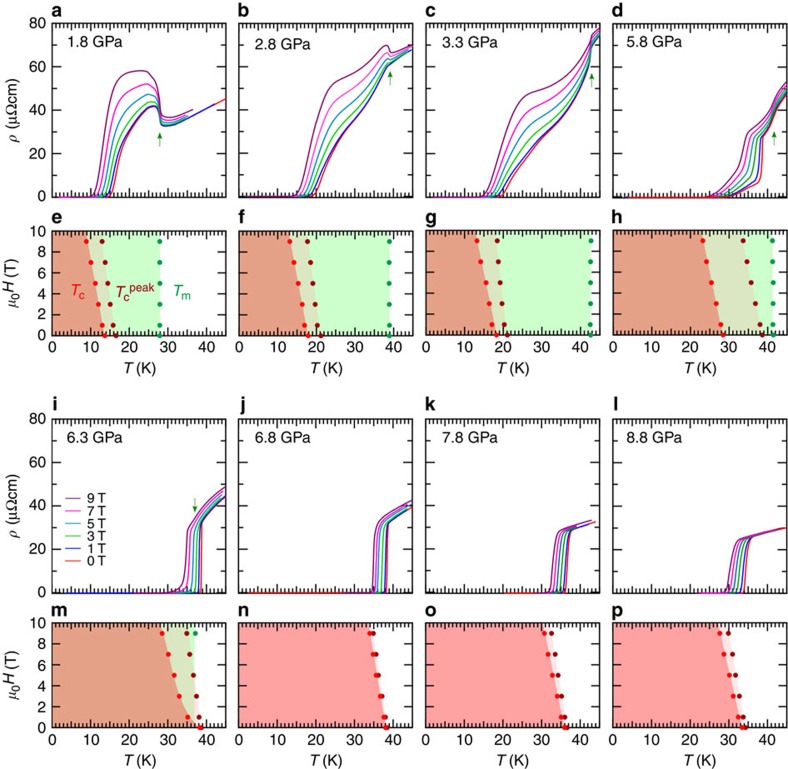
Effects of magnetic fields on the magnetic and superconducting transitions under high pressure.(a–d, i–l) ρ(T) curves at different magnetic fields applied parallel to the c axis. The magnetic transition temperature Tm is field independent and marked by the green arrow (a–d). At 6.3 GPa, the Tm anomaly is only visible at high fields (i). (e–h, m–p) H-T phase diagrams. The zero resistivity is attained below Tc and the  line (determined by the peak in dρ/dT(T)) is a lower bound of upper critical field Hc2. The sharp superconducting transitions under magnetic fields for P>6.3 GPa indicate narrowed regimes of the vortex liquid state.